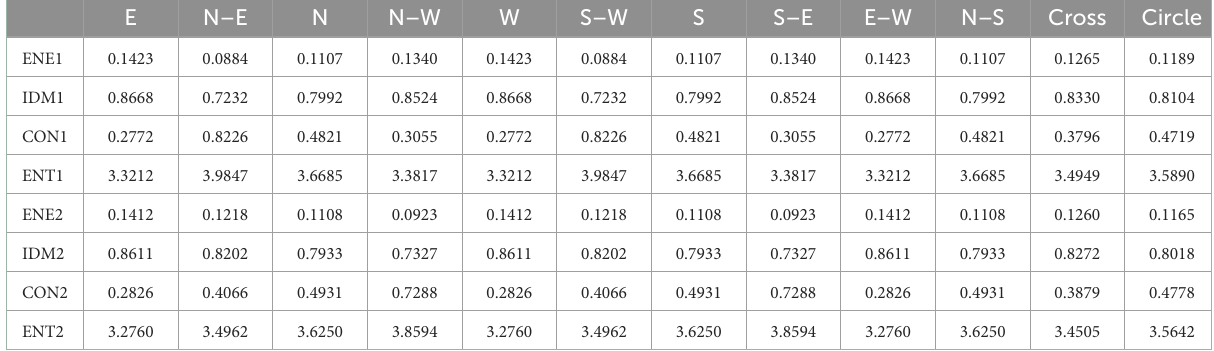
TABLE 5 Relevant calculation data for quantitative analysis of echo homogeneity of white matter in plane two.